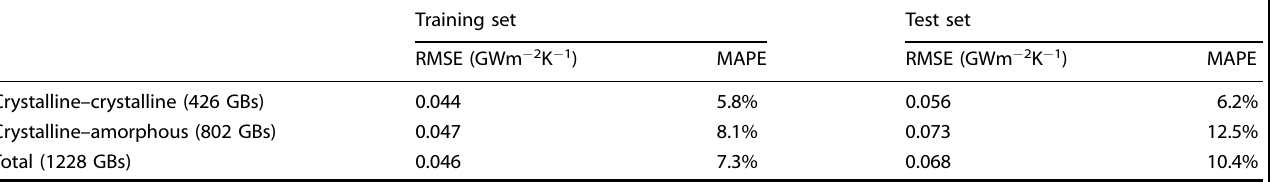
Table 2. Summary of thermal boundary conductance (TBC) prediction results on training and test